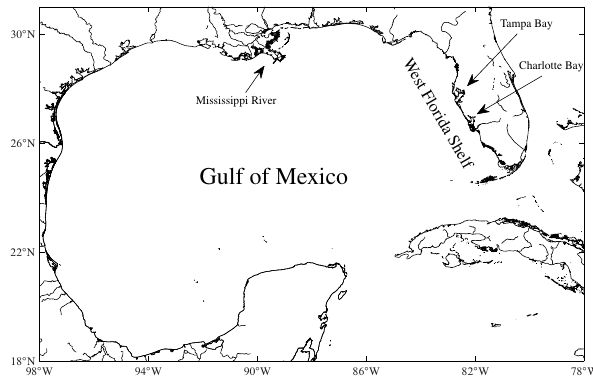
Fig. 1. Map showing the region of study.